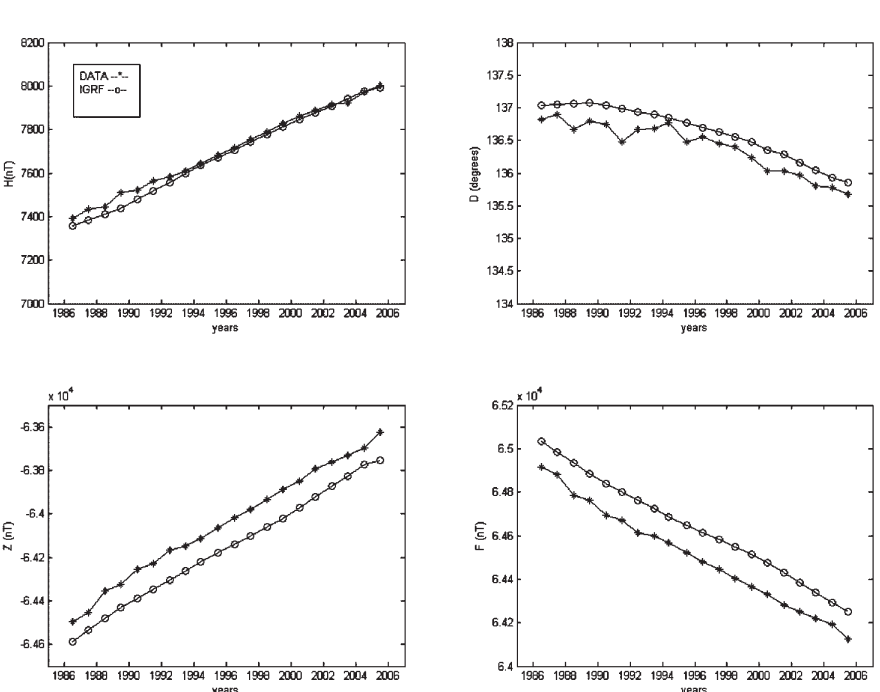
Fig. 3. Long-term time evolution of the H, D, Z and F elements at Mario Zucchelli Station, shown by their sum- mer mean values (stars) and corresponding IGRF values (circles)